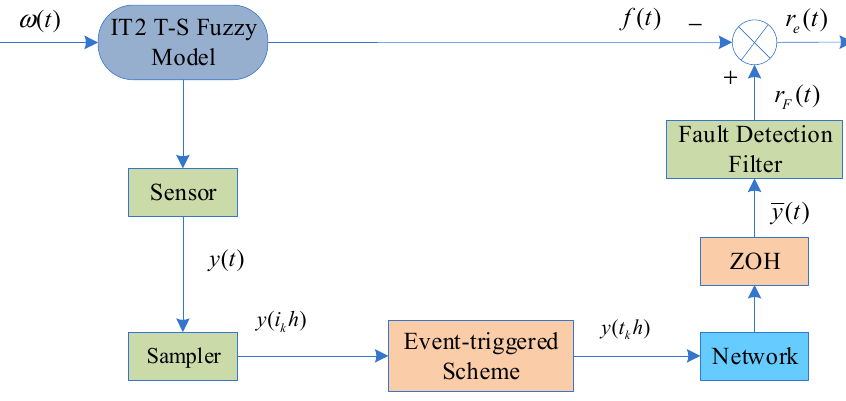
Figure 1. Framework of IT2 T-S NNSs with event-triggered scheme.